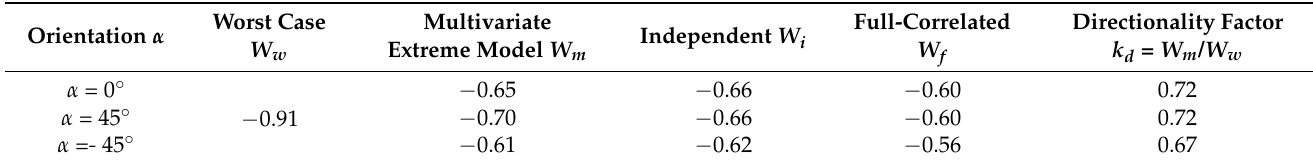
Table 2. Comparisons of mean value of extreme wind loading on solar arrays located in Jinan, China, using different methods (Units: kN/m 2